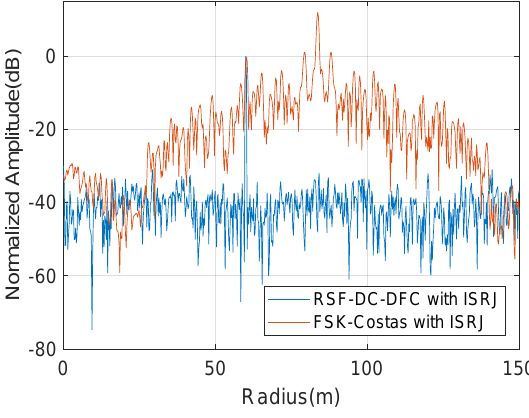
Figure 11. Radius slice